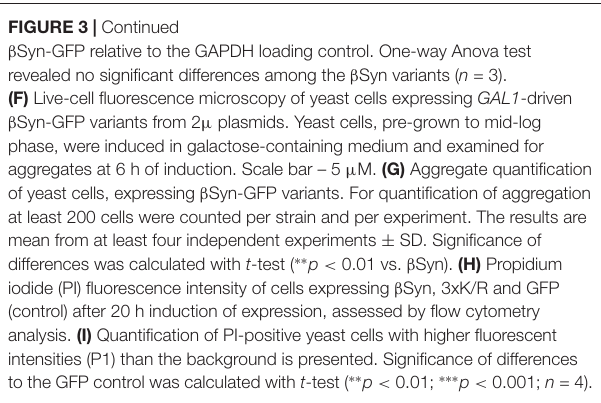
FIGURE 3 | Continued β Syn-GFP relative to the GAPDH loading control. One-way Anova test revealed no significant differences among the β Syn variants ( n = 3). (F) Live-cell fluorescence microscopy of yeast cells expressing GAL1 -driven β Syn-GFP variants from 2 µ plasmids. Yeast cells, pre-grown to mid-log phase, were induced in galactose-containing medium and examined